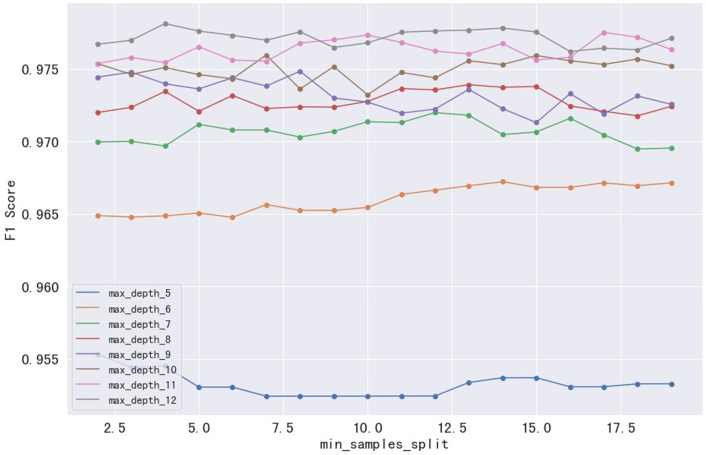
max_ depth and min_ samples_ split joint parameter adjustment.